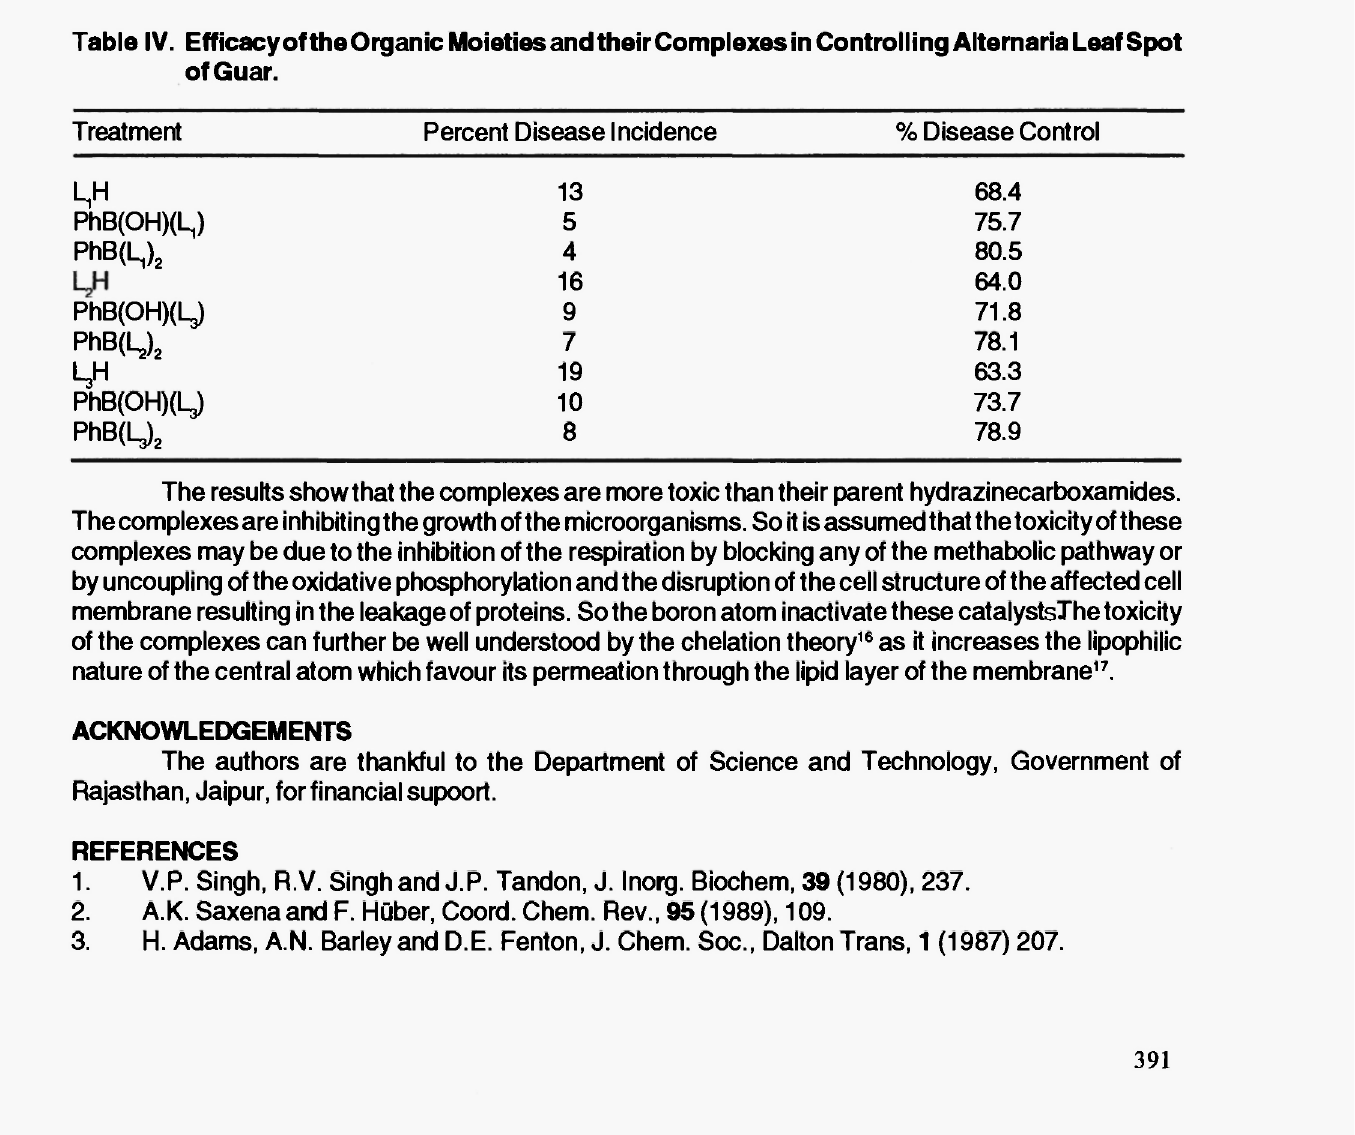
Table IV. EfficacyoftheOrganic Moieties and their Complexes in Controlling AlternariaLeaf Spot of